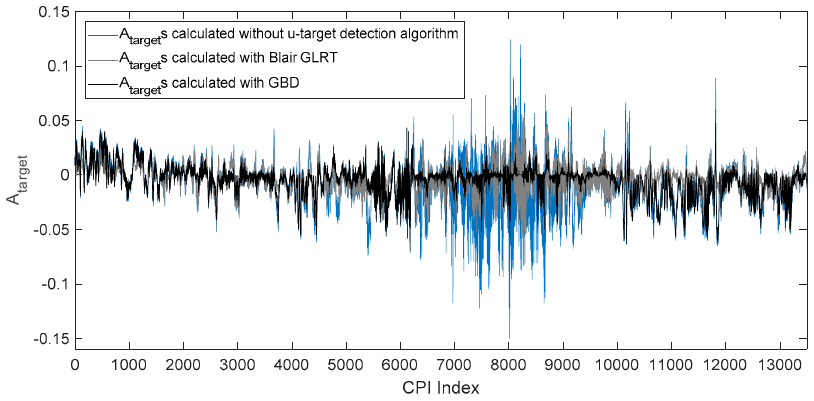
Figure 9. A target s calculated with or without unresolved targets detection algorithms. Figure 9. 𝐴 (cid:2930)(cid:2911)(cid:2928)(cid:2917)(cid:2915)(cid:2930) s calculated with or without unresolved targets detection algorithms. Table 2. Variance of target angle in typical time